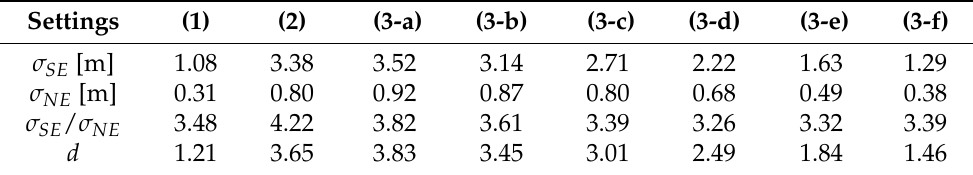
Table 3. Standard deviations, their ratios, and RMSEs with different process noise settings.